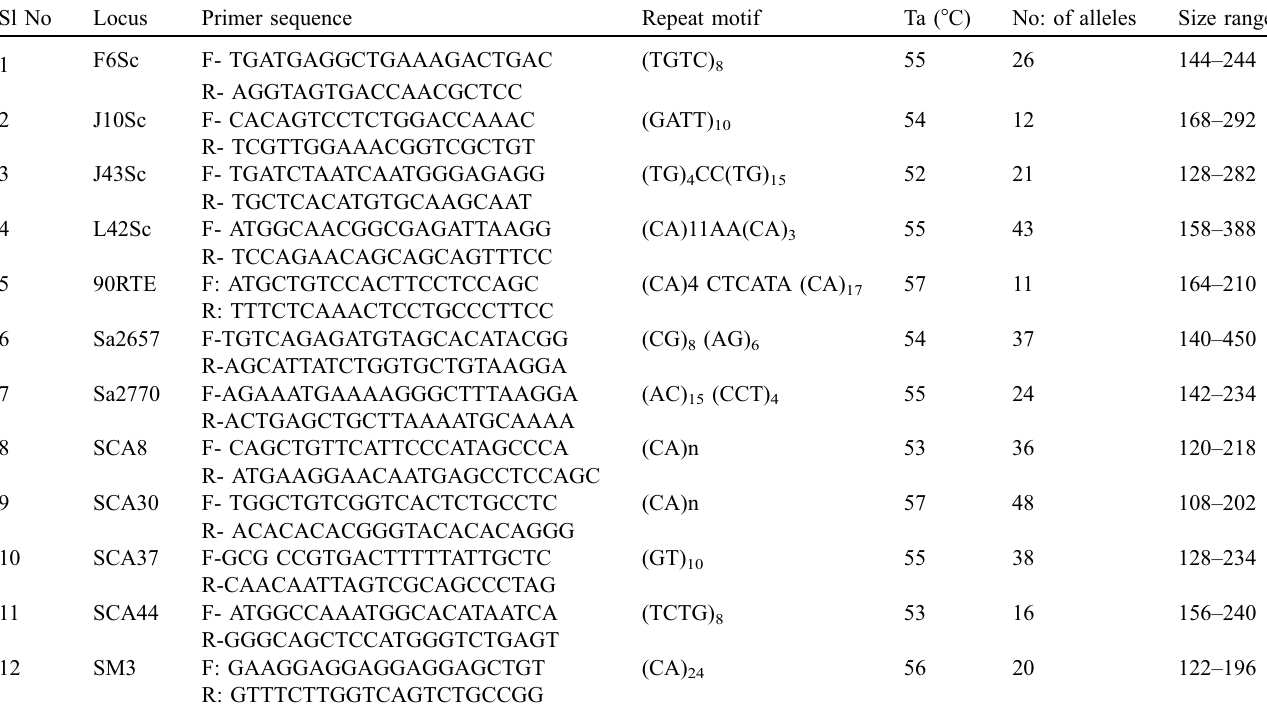
Table A1. Details of polymorphic microsatellite loci used for stock structure analysis in S. commerson.